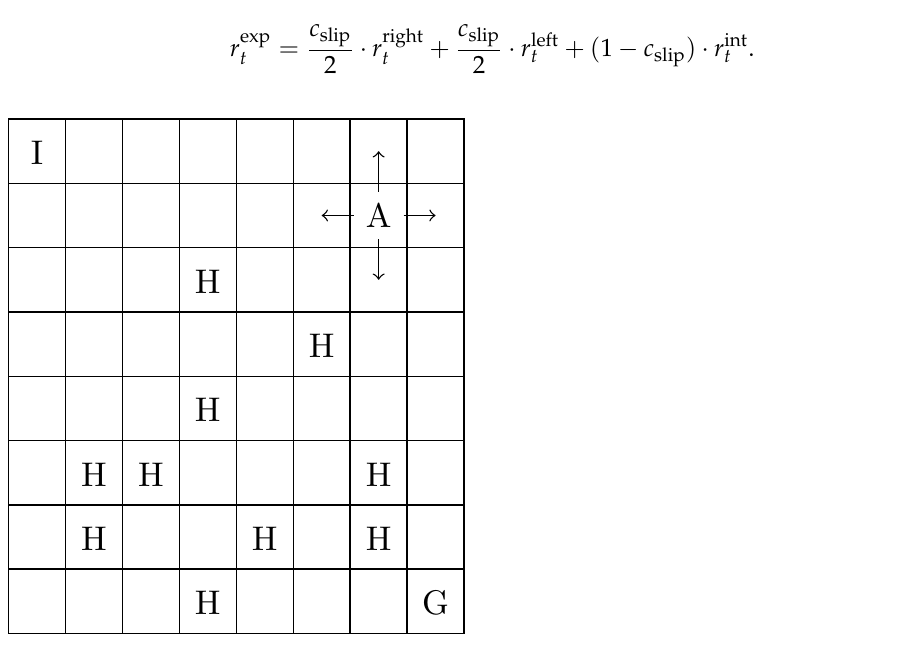
Figure 1. The FrozenLake8x8-v0 environment from OpenAI Gym